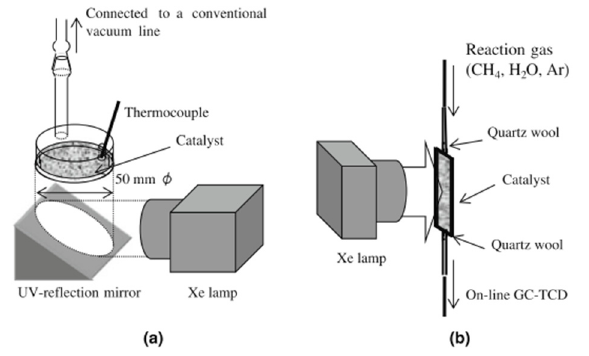
Figure 9. Example of a reactor for photocatalytic methane reforming: ( a ) a closed reactor and ( b ) a flow reactor [29]. Reprinted by permission from [30]. Copyright (2014), Springer Nature. GC-TCD: gas chromatography-thermal conductivity detector.